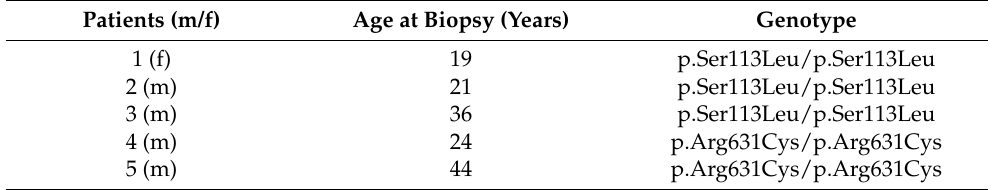
Table 1. Epidemiological and molecular genetic data of patients. Patients (m/f) Age at Biopsy (Years)